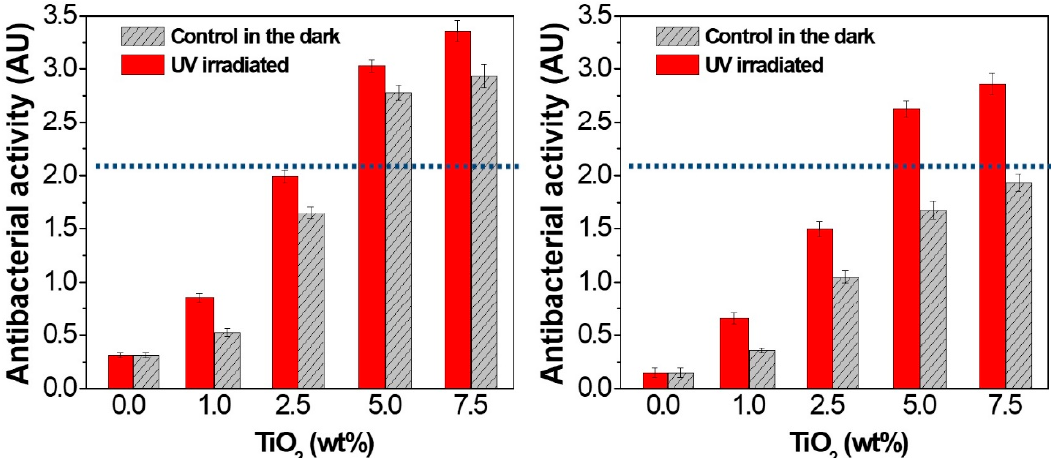
Figure 11. Antibacterial action of AELO/TiO 2 nanocomposites versus S. aureus (left) and E. coli (right). The dotted line shows the limit for effective antibacterial action. Reprinted from [46], copyright 2015, with permission from the Royal Society of Chemistry.